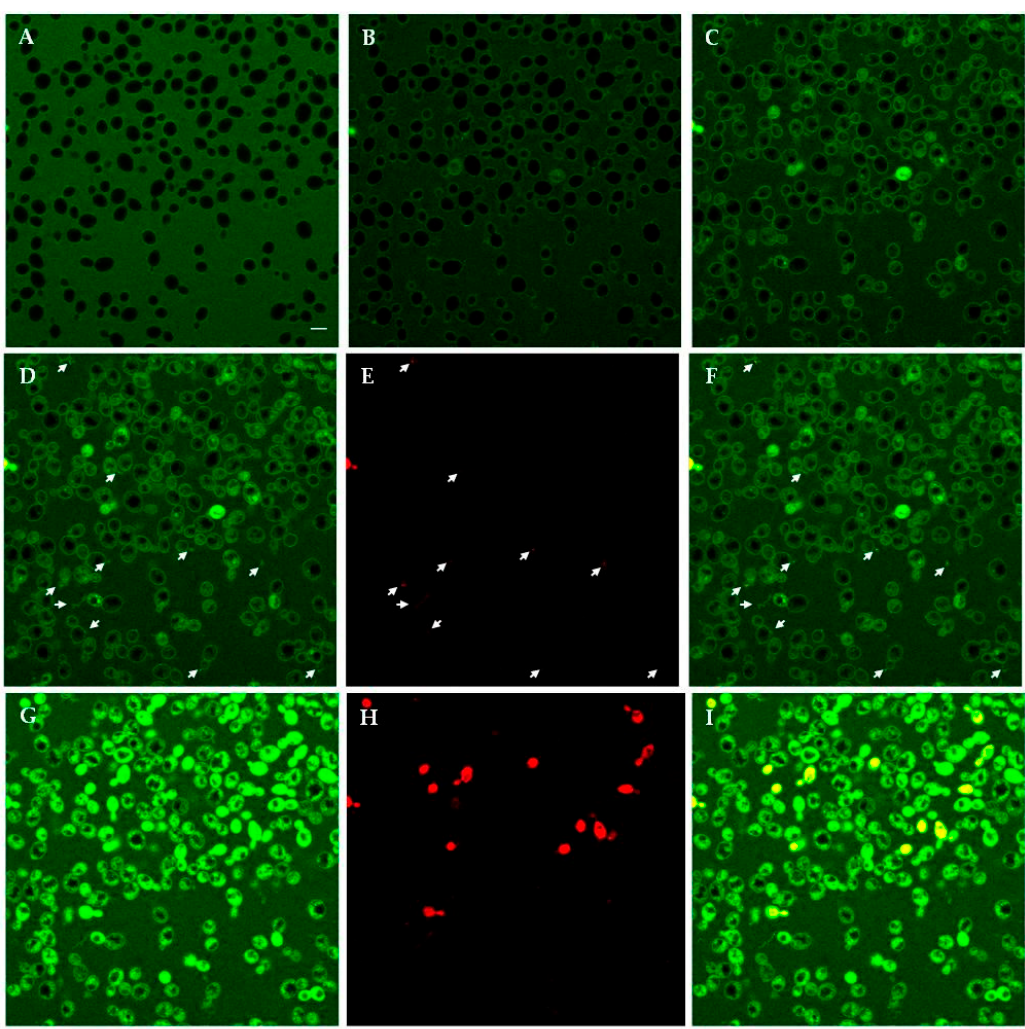
Figure 6. Interaction between Candida albicans SC5314 cells and fluorescein isothiocyanate (FITC)-labelled D5A followed in time-lapse confocal microscopy. The same field is shown. Living yeast cells were incubated in the presence of FITC-labelled D5A for 5 min ( A ), 60 min ( B ), 170 min ( C ), 220 min ( D ), and 390 min ( G ). Panels E and H : PI staining at 220 and 390 min, respectively. Panels F and I : merge of panels D and E , and G and H , respectively. Arrows in panels D , E , and F indicate the leakage of material from yeast cells. Bar = 5 μ m.